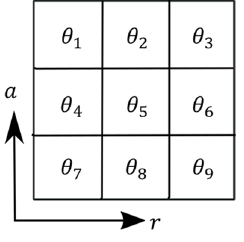
Figure 5. 3 × 3 Grid kernel.